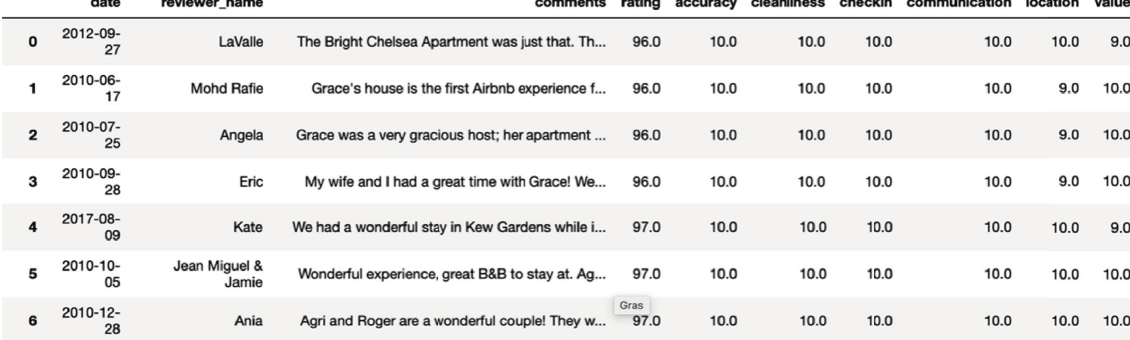
Figure 1: Extraction of the dataset collected after crossing and